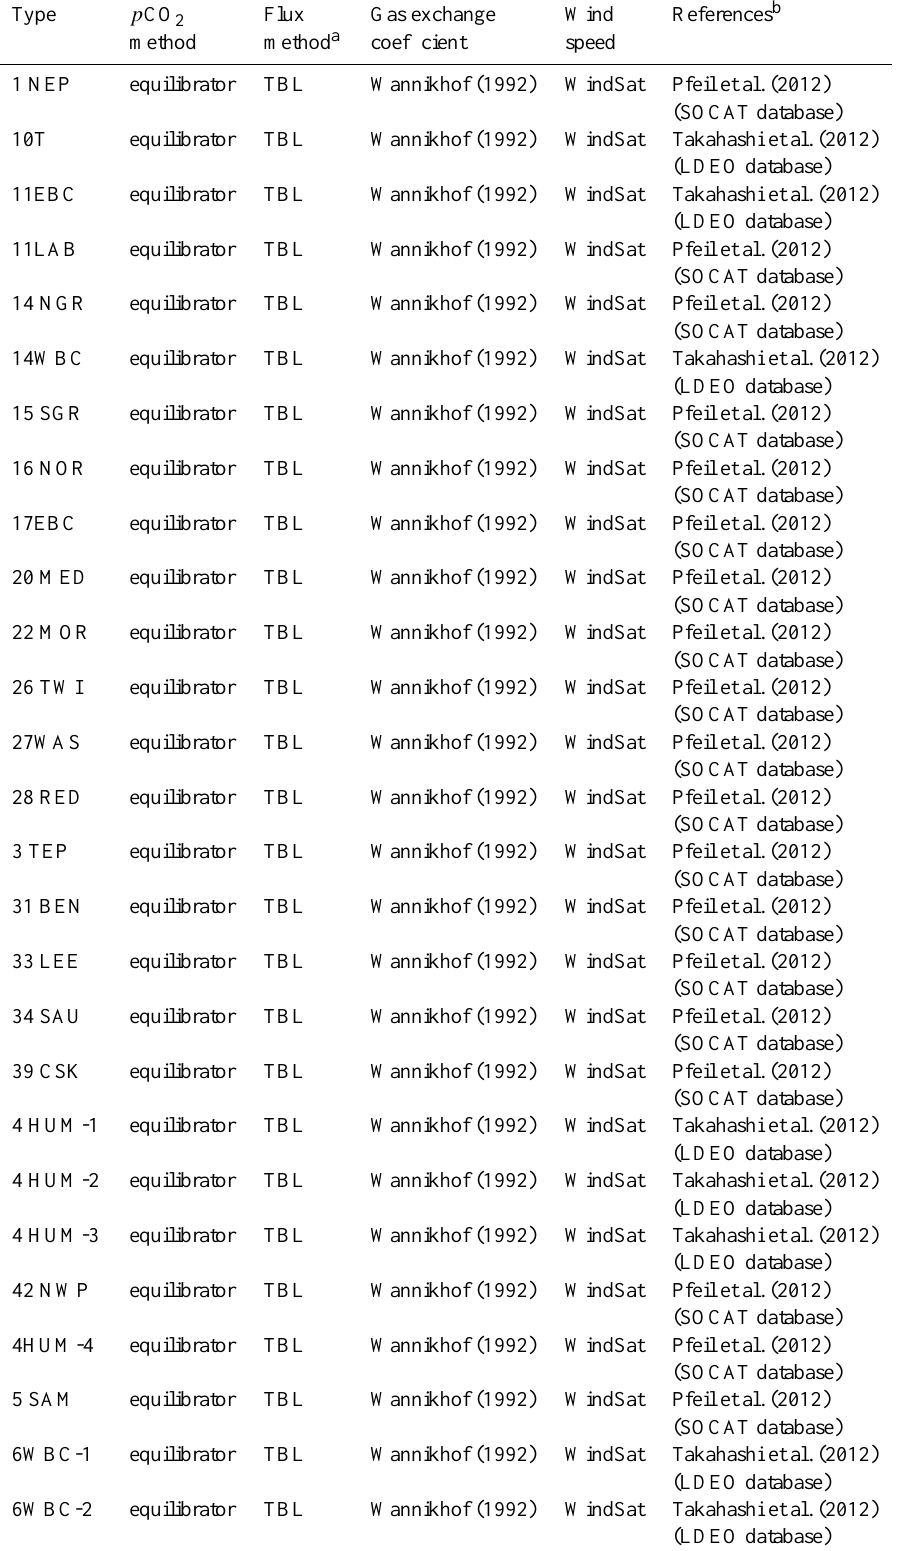
Table 6. The p CO 2 and flux method, the gas exchange coefficient and the wind speed in the world’s continental